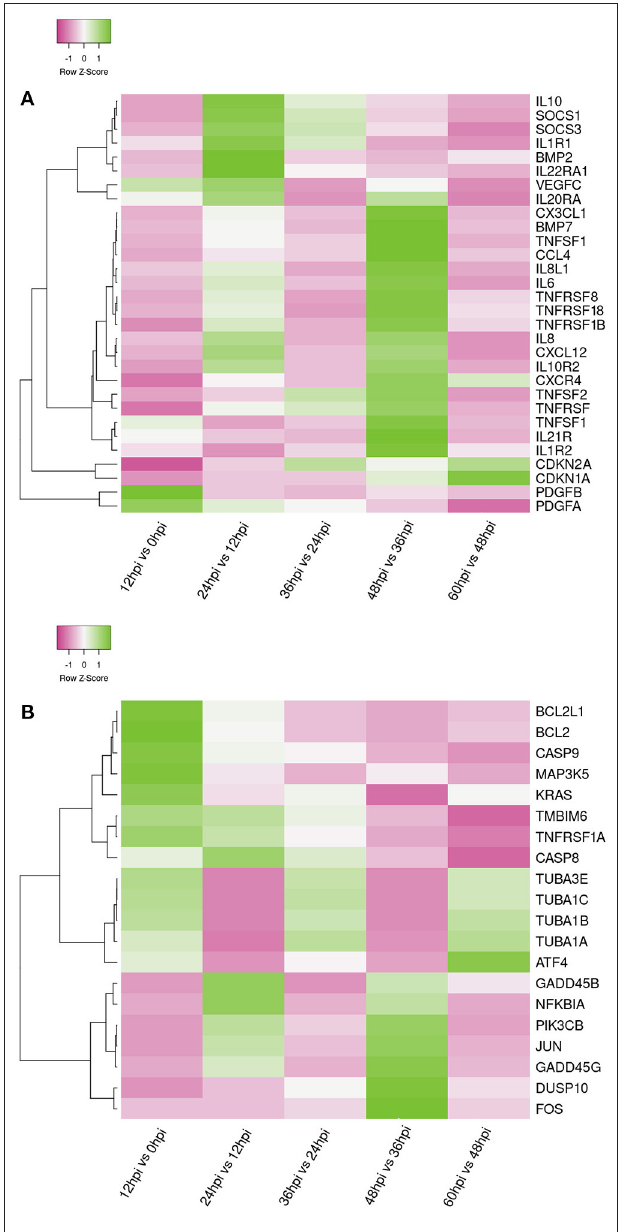
FIGURE 5 | Heat maps shows the hierarchical clustering of genes involved in apoptosis genes (A) and Immune-related genes (B) at five time points. The color in the heat map represents the normalized isotig number. The color in the heat map represents gene expression changes (green, high gene expression; pink, low gene expression; white, no gene expression). DEGs are labeled on the left of the heat-map line.